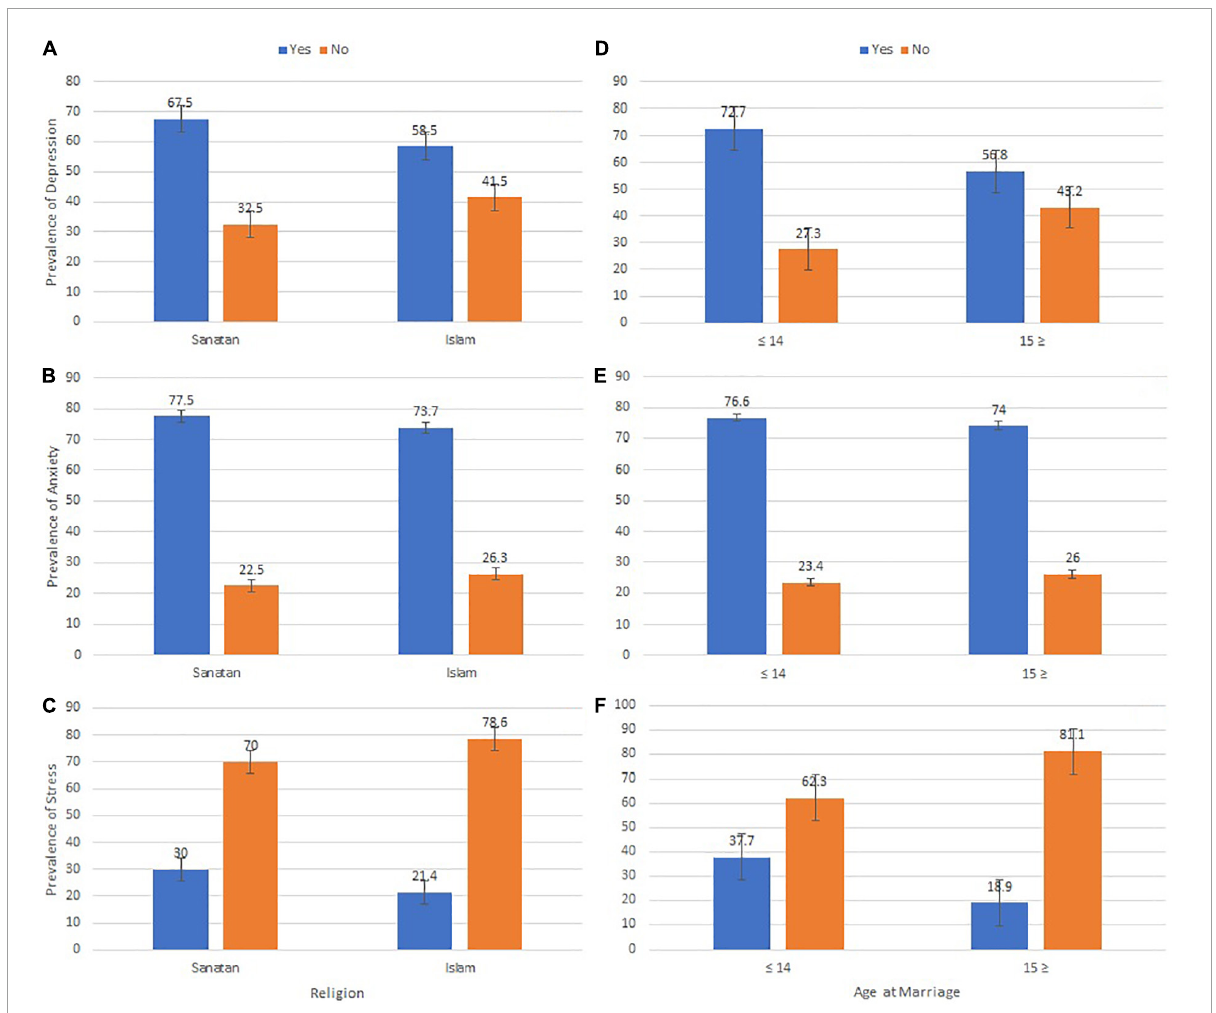
FIGURE1 Prevalence and standard error of depression (A,D) , anxiety (B,E) , and stress (C,F) among early married girls in